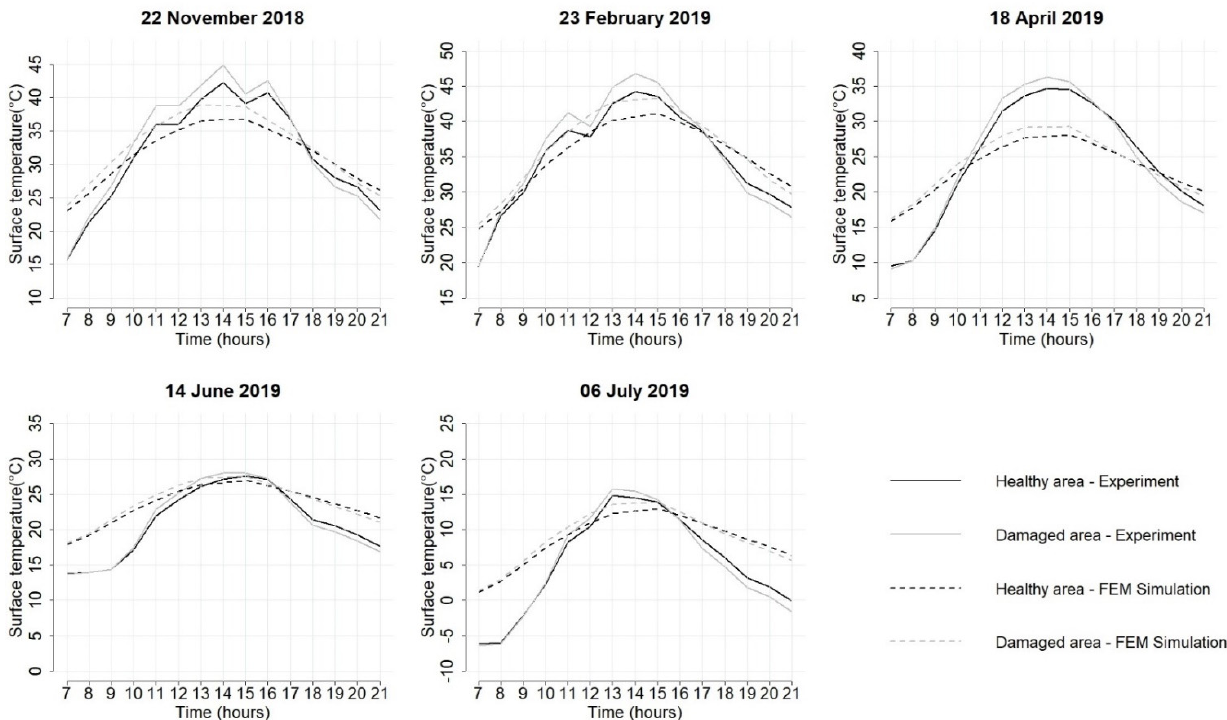
Figure 5. Comparison of surface temperatures measured in the IRT experiment and simulated by the FEM.